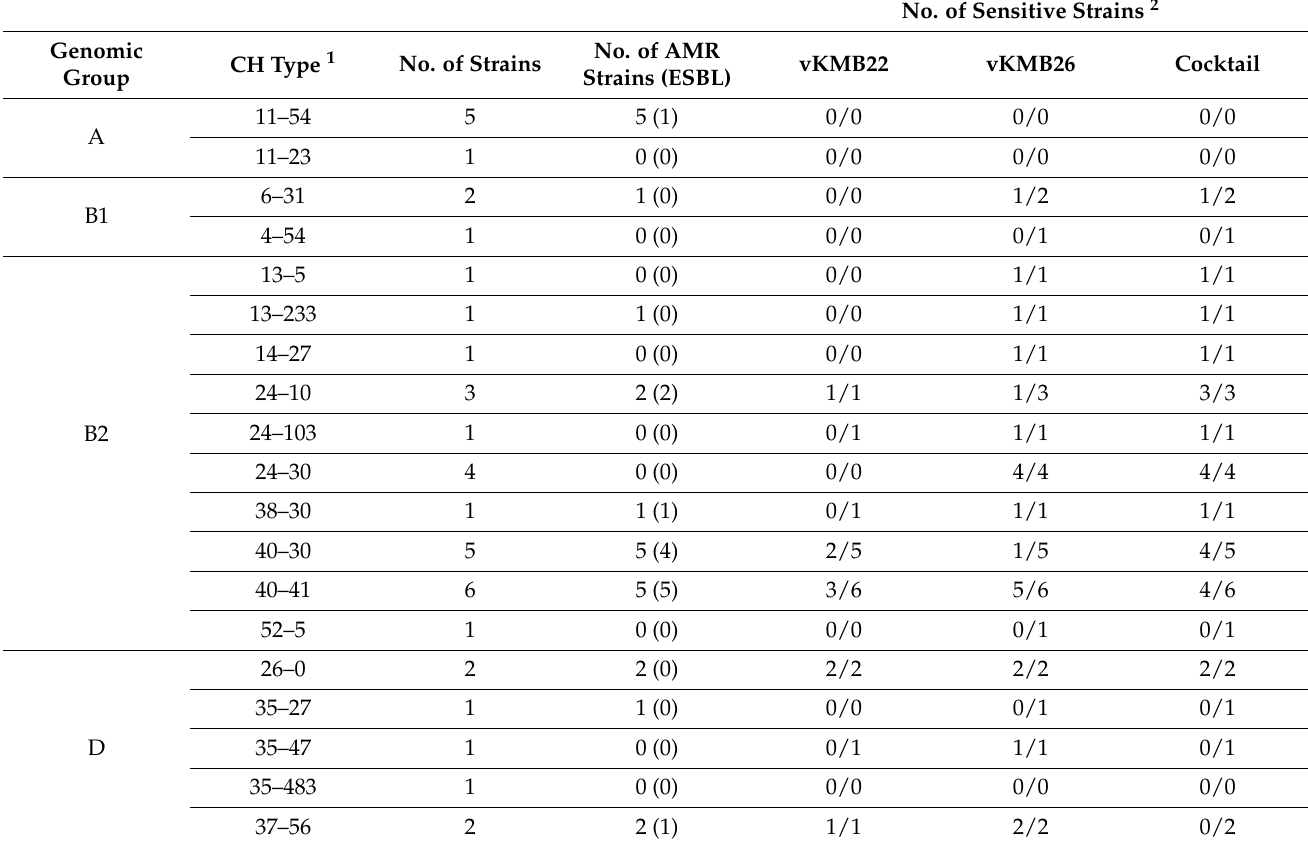
Table 1. Sensitivity of Escherichia coli strains to the new phages and their cocktail.